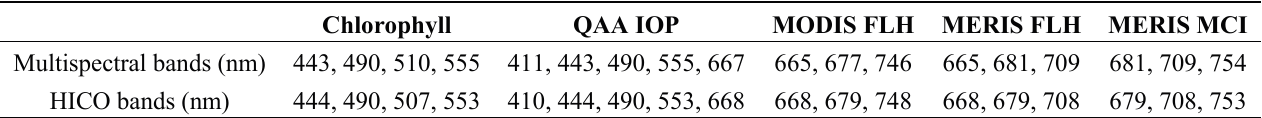
Table 1. Center wavelengths of Hyperspectral Imager for the Coastal Ocean (HICO) bands used in algorithm